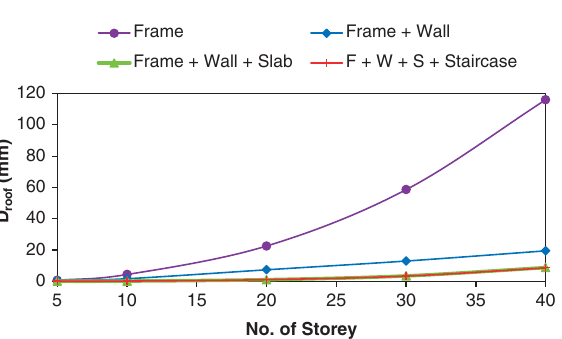
Fig. 11. Roof displacement, D roof , for different con fi gurations compared to staircase inclusion